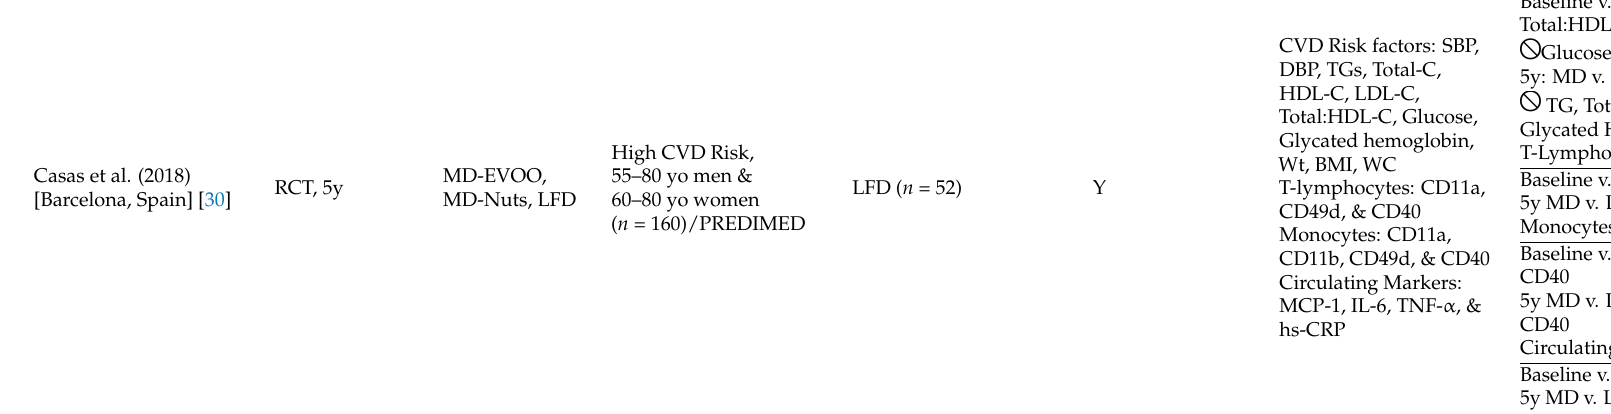
Table 2. Clinical Studies.